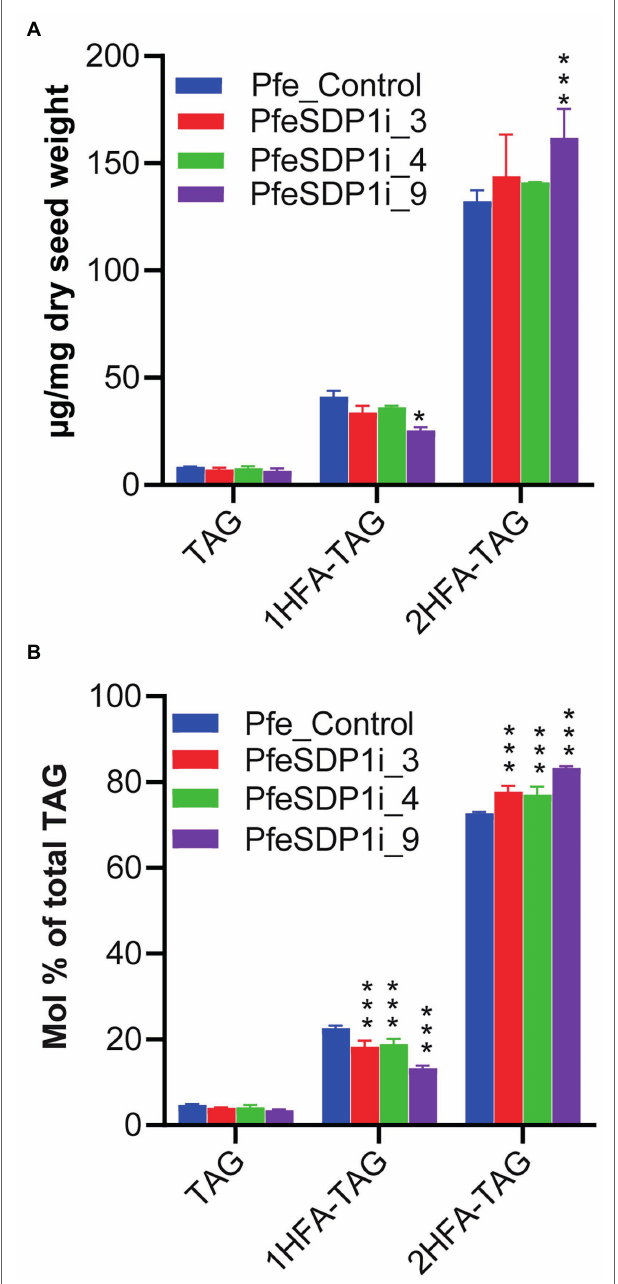
FIGURE 6 | Analysis of different TAG species in the seeds of SDP1 RNAi lines. The levels of different TAG molecular species were expressed as μ g/mg dry seed weight (A) and relative percent (mol%) of total TAG (B) . 1HFA-TAG and 2HFA-TAG represents TAG with one and two hydroxy fatty acids, respectively. Significant difference between wild-type control and PfeSDP1 knock-down lines was determined using two-way ANOVA (*** p ≤ 0.001 and * p ≤